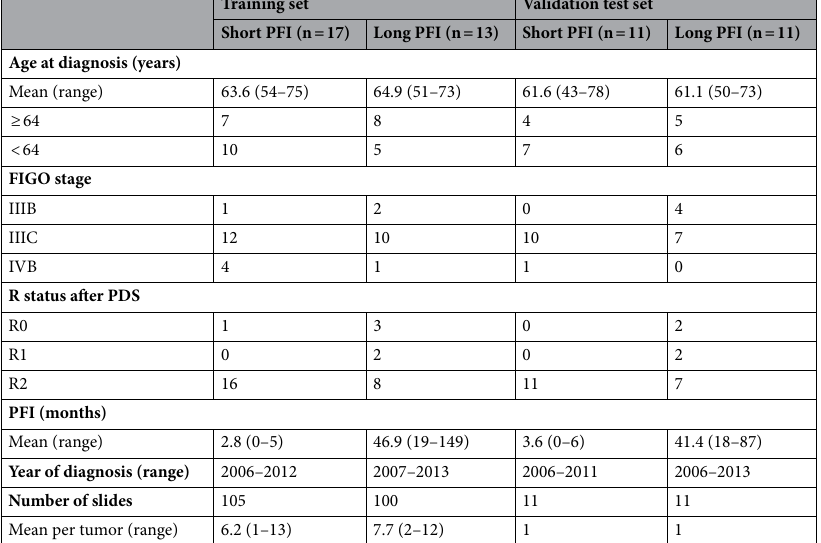
Table 1. Clinicopathologic features summary.